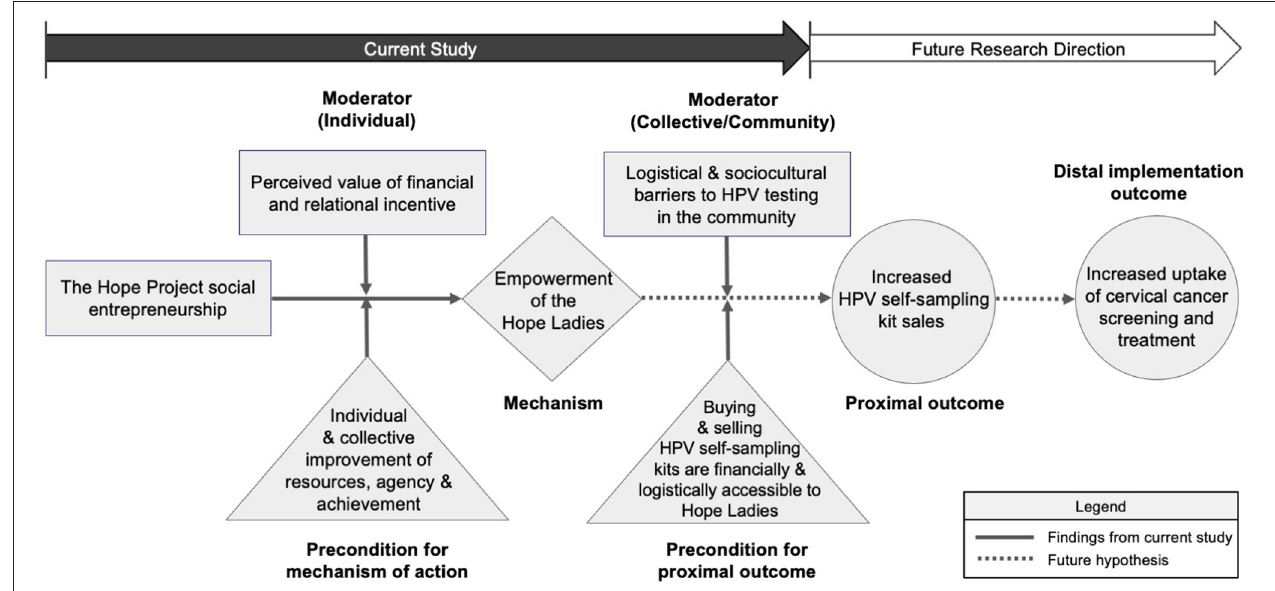
FIGURE 4 | Empowerment as the potential mechanism of action for the Hope